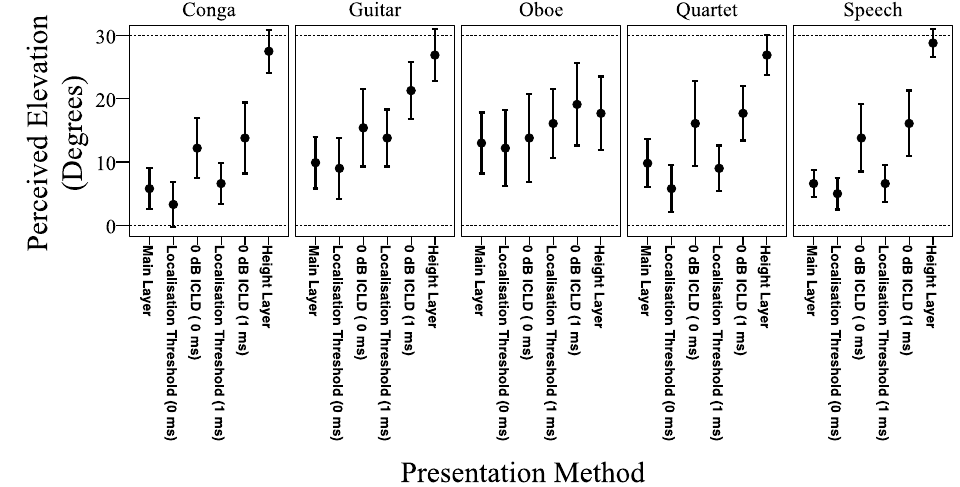
Figure 9. Medians and associated notch edges for the results of the verification test showing the perceived elevation of each of the test stimuli. The dotted lines at 0 and 30° represent the physical positions of the main and height layers respectively. ICLD: interchannel level difference In order to further determine whether or not the localisation thresholds derived from